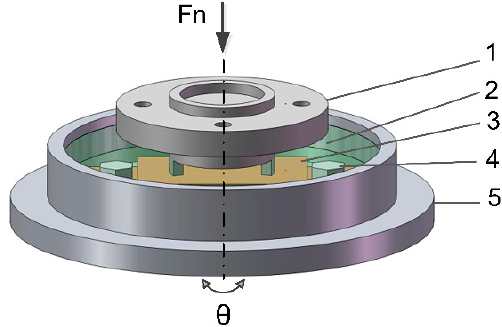
Figure 3. Schematic of the test rig: 1-Upper specimen; 2-Lubricant; 3-Lower specimen; 4-Screw; and 5-Lubricant tank.